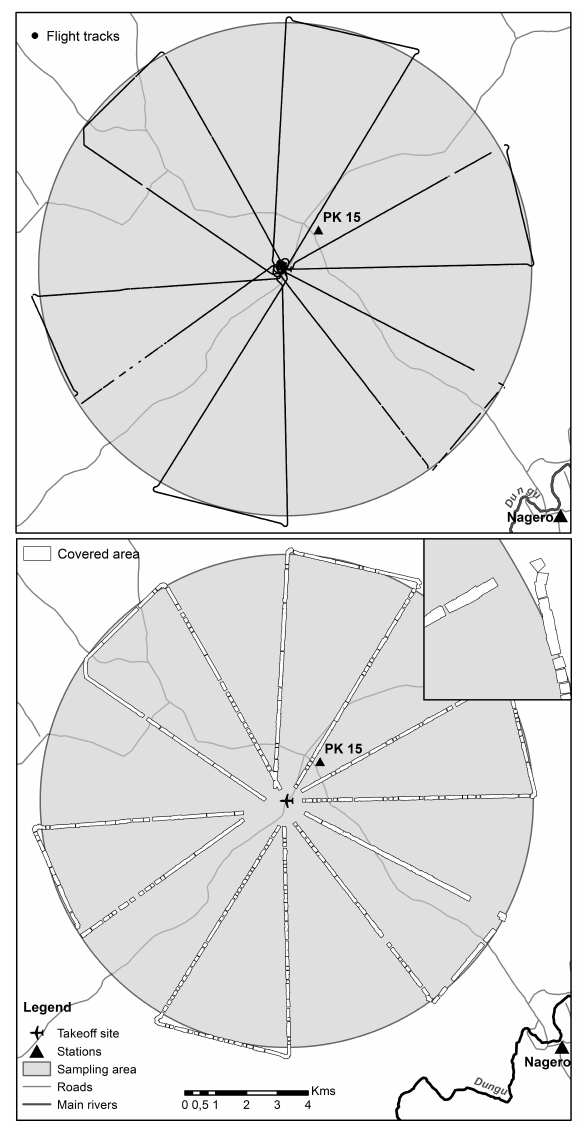
Figure 5. Top: UAV flight tracks for the first inventory trial. Each flight covers two triangles, starting with the North direction. Bottom: area covered by the first inventory obtained by projecting and merging image footprints after discarding take-off and landing parts